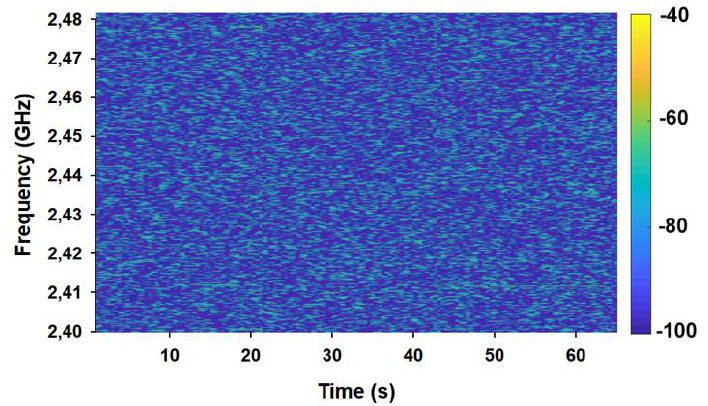
Figure 16. Spectrogram measured before starting the measurement campaign.